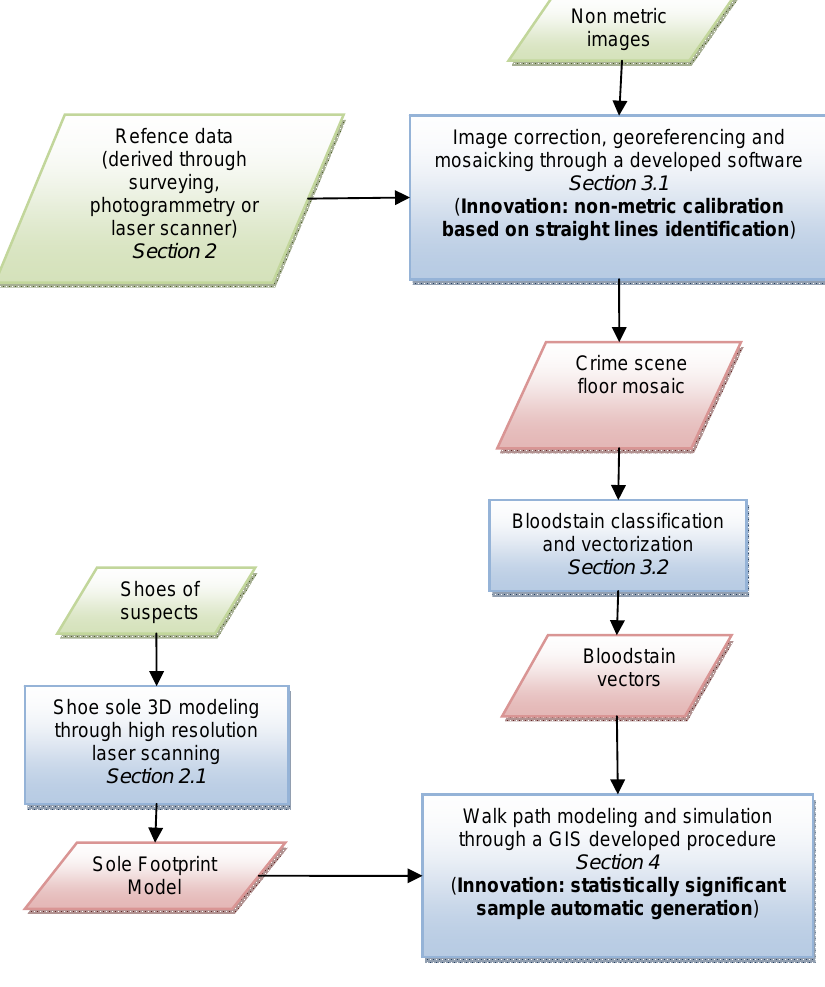
Figure 1. Schema of the developed